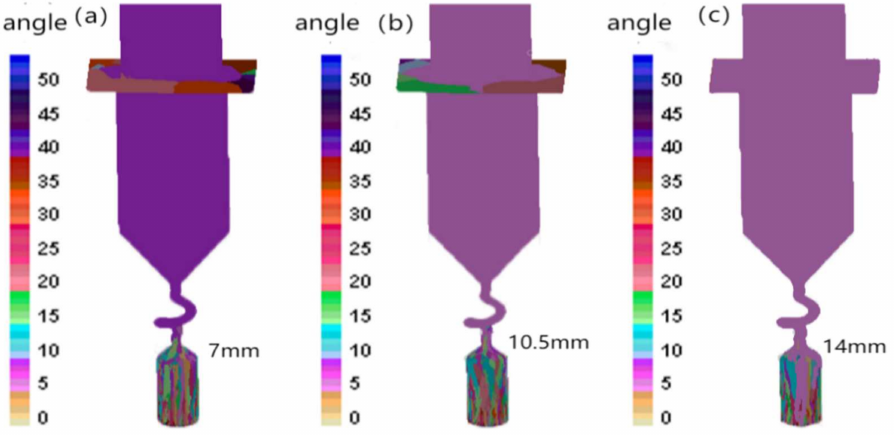
Figure 7. Simulation results of CAFE grain structure with variable wall thickness: ( a ) 7 mm; ( b ) 10.5 mm; ( c ) 14 mm.